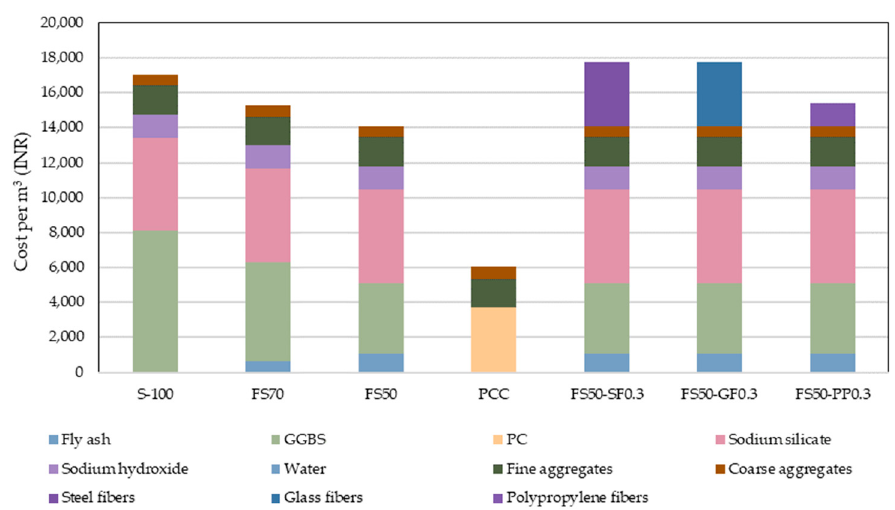
Figure 11. Cost analysis of AAC, FRAAC, and PC concrete.